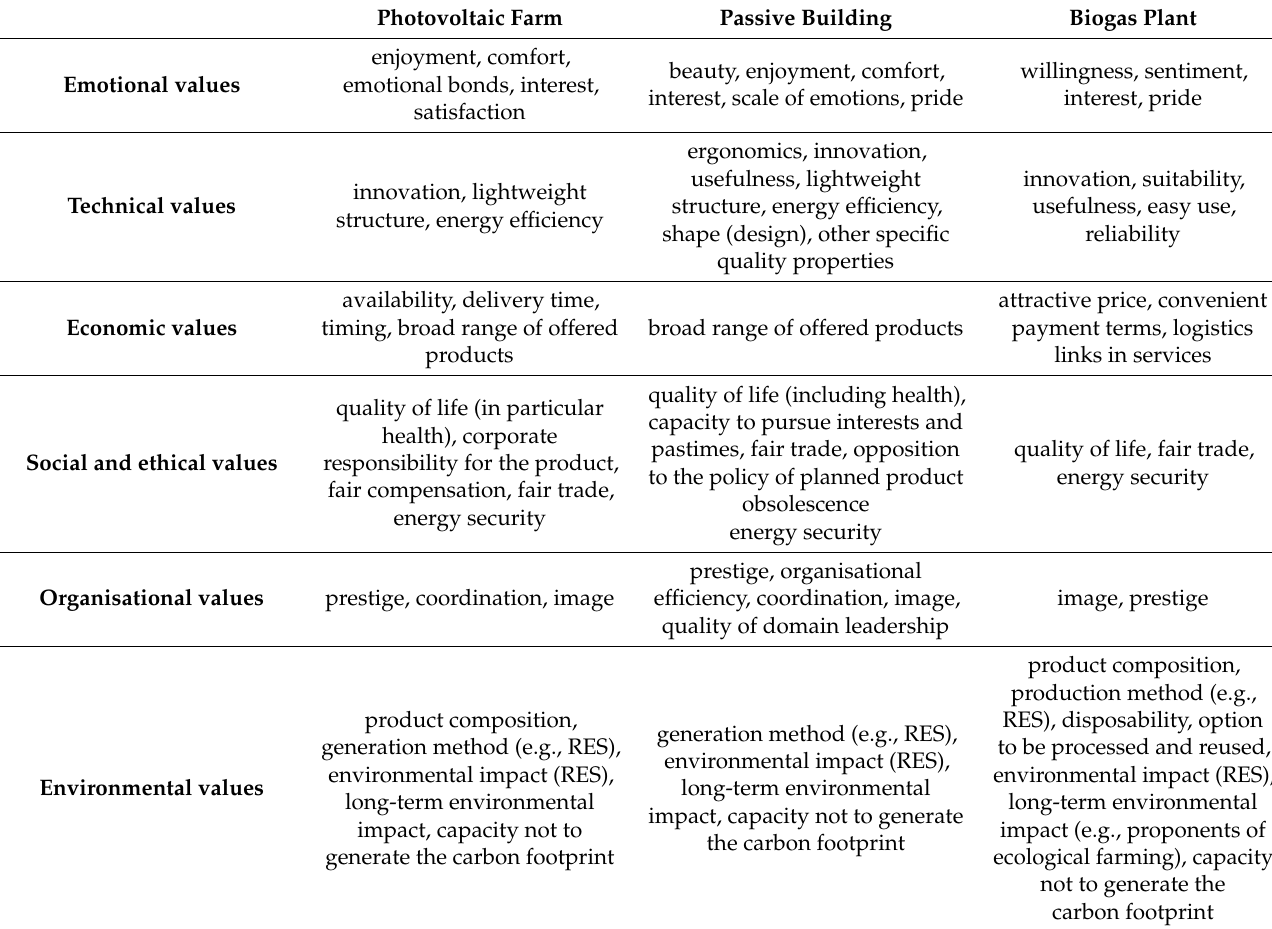
Table 9. Values created by the selected innovative energy generation